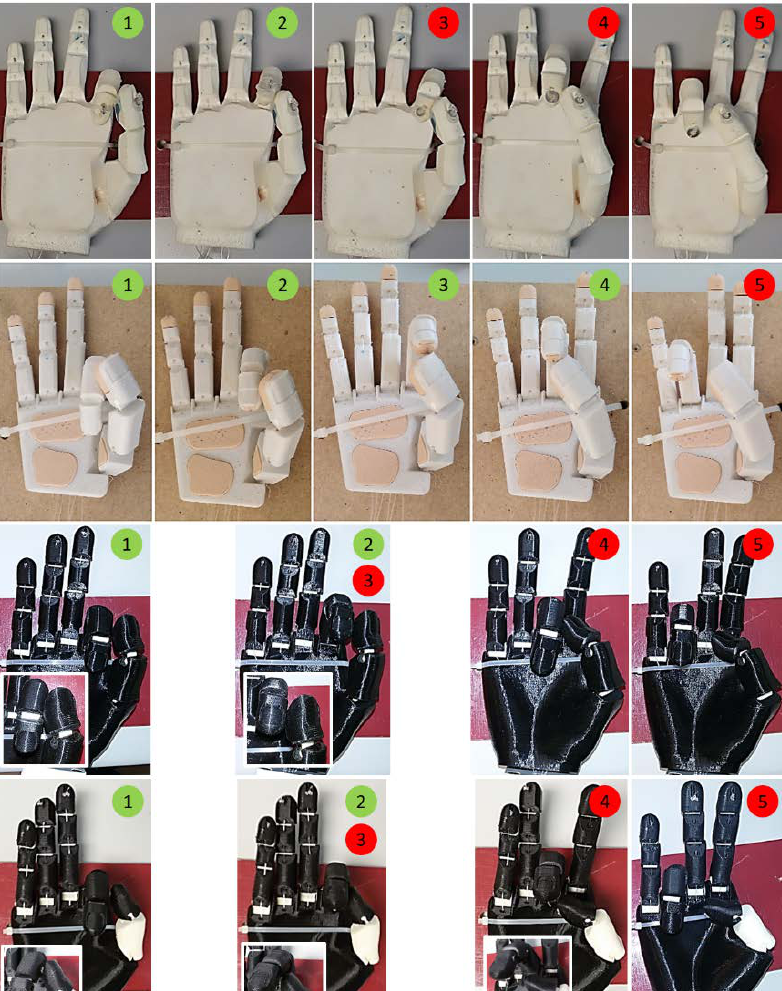
Figure 6. Results for the Kapandji test of the hands in the present research: from top to bottom, Dextrus, IMMA, Lb-45, and Lb-0 (green indicating success, red fail). Points 0 and 6 are not shown since no hand achieved them.